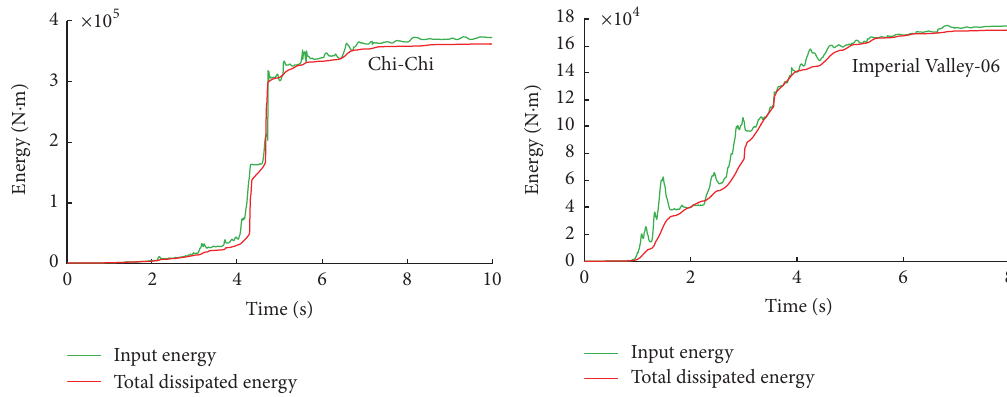
Figure 6: Comparison of input energy and total dissipated